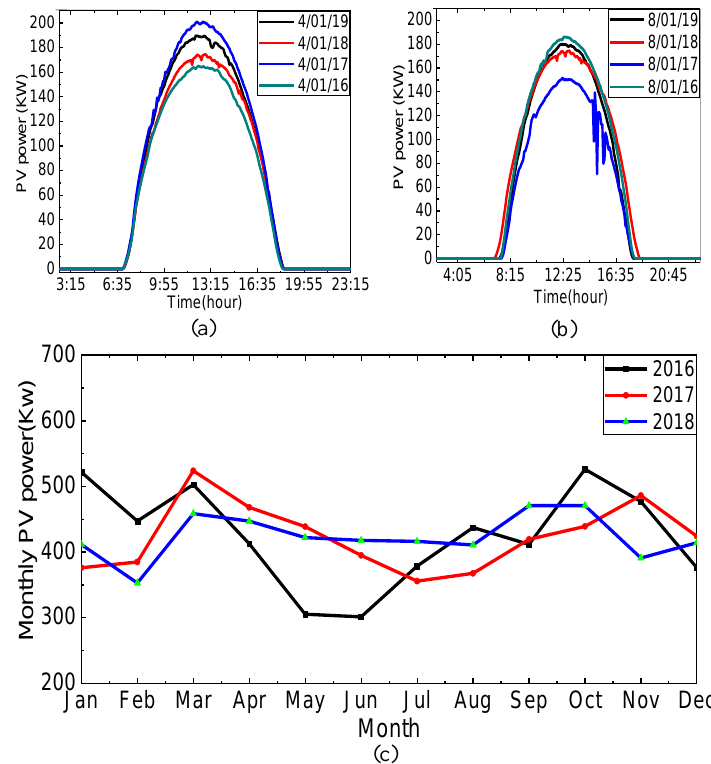
Figure 7. PV power variation ( a ) on April 1st in the past 4 years ( b ) on August 1st in the past 4 years ( c ) between